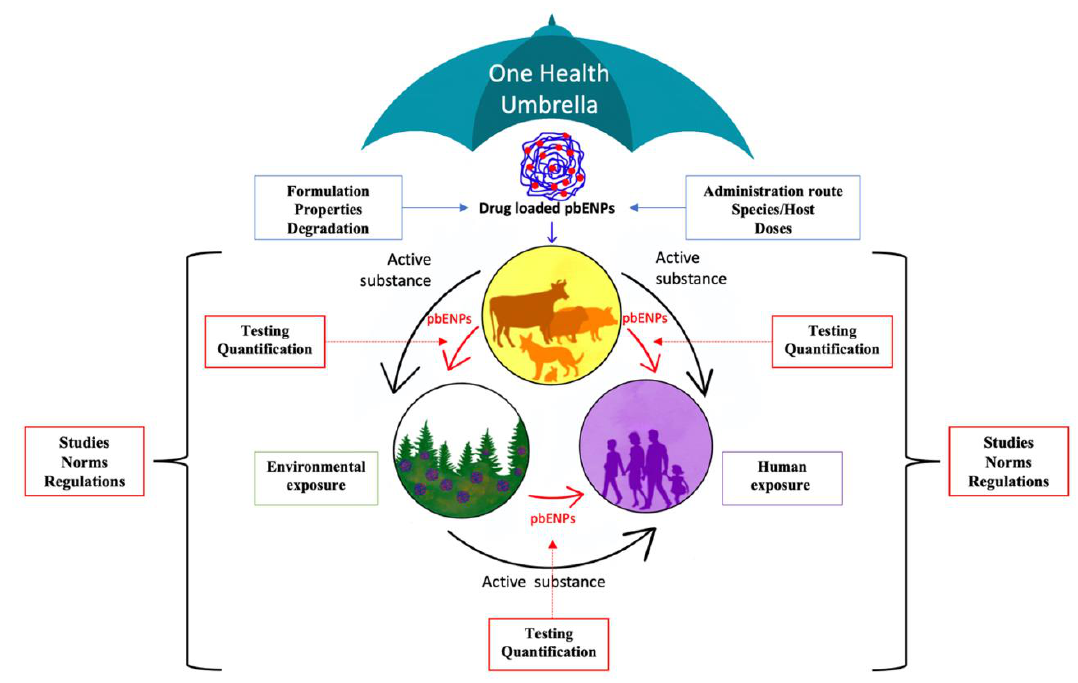
Figure 1. Fate of pbENPs when used in veterinary science—a One Health approach (overview).